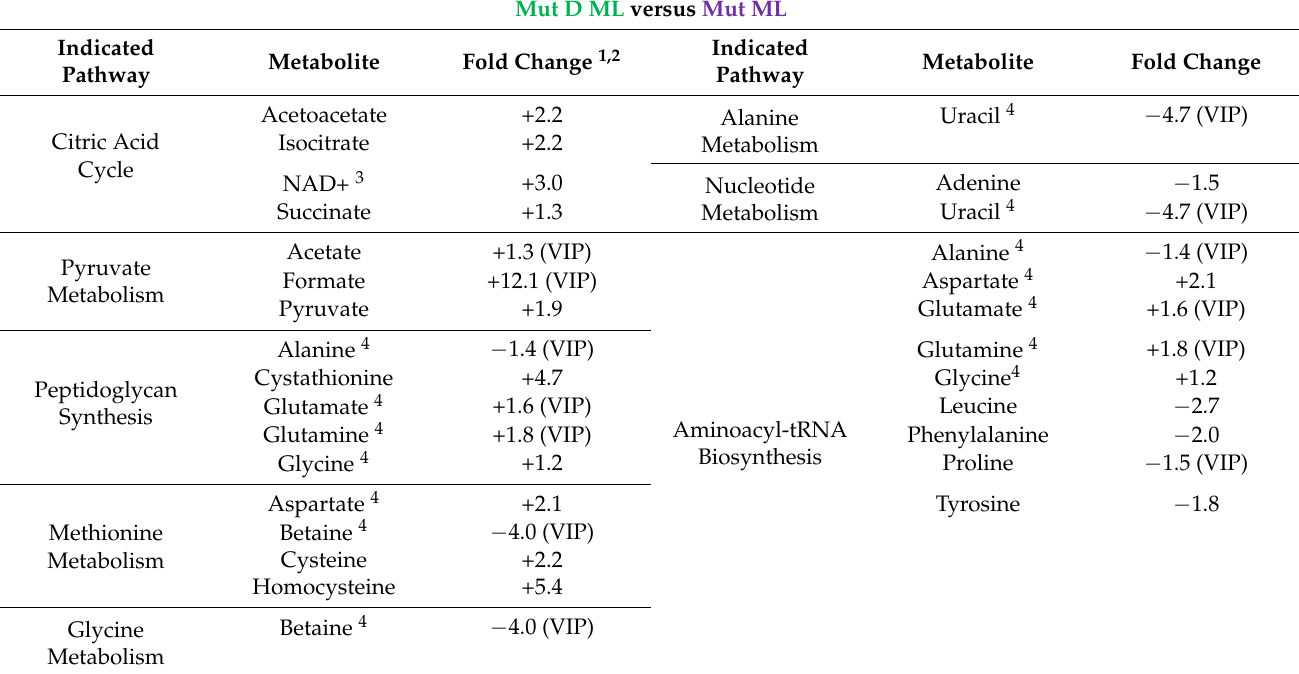
Table 8. Fold change of statistically significant metabolites in their corresponding metabolic pathways for the mid log phase of DABCOMD challenged mutant versus unchallenged